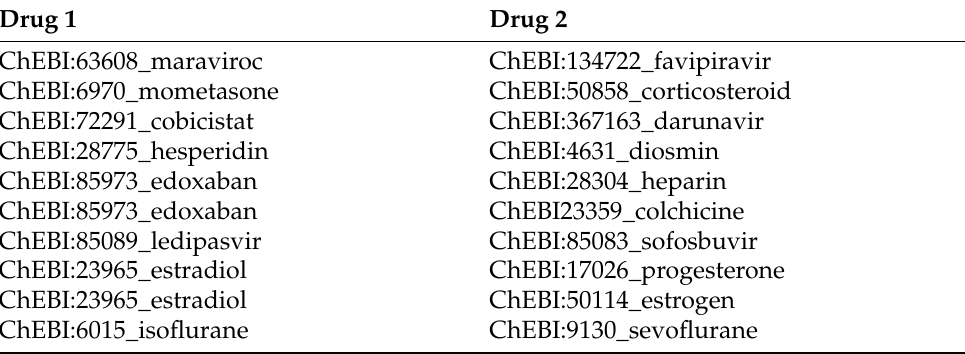
Table 2. Cliques of size two (drugs qualified with their ChEBI ID) detected from clinical trials association